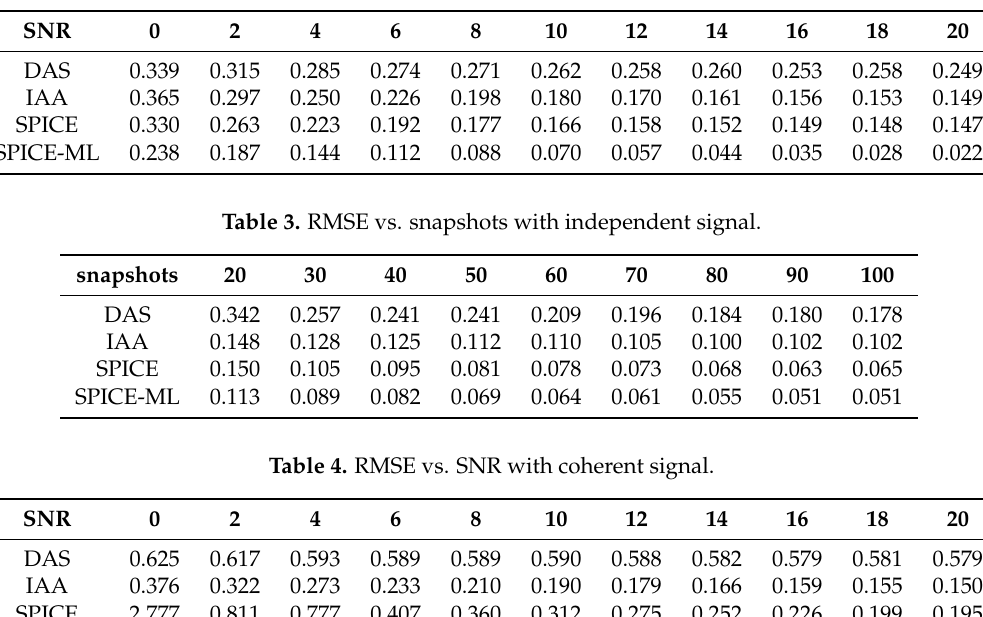
Figure 5. RMSE with coherent signal. Table 2. RMSE vs. signal to noise ratio (SNR) with independent signal.